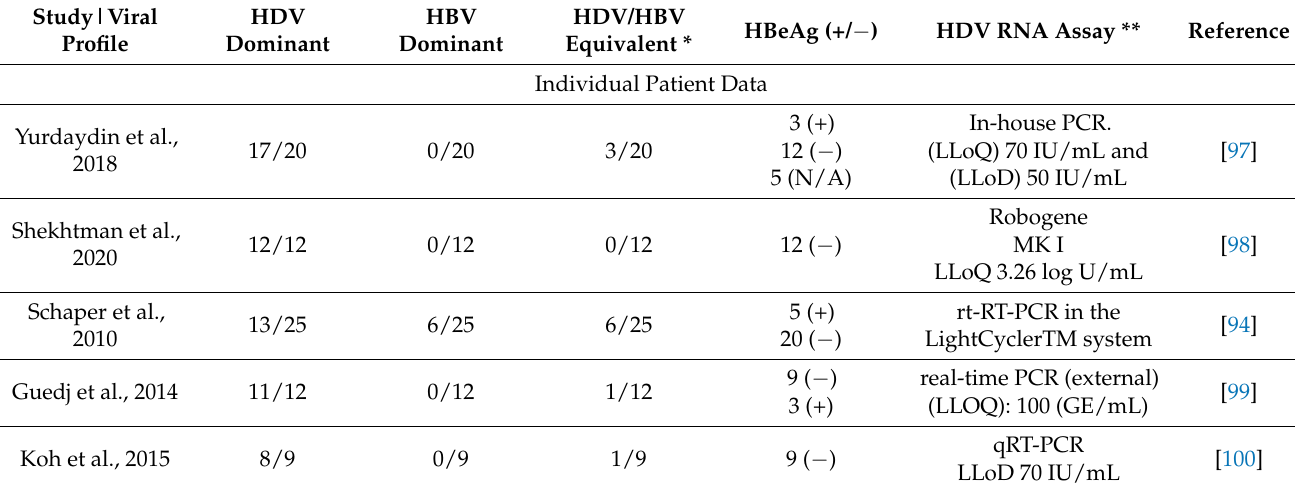
Table 1. HDV RNA and HBV DNA profiles during chronic